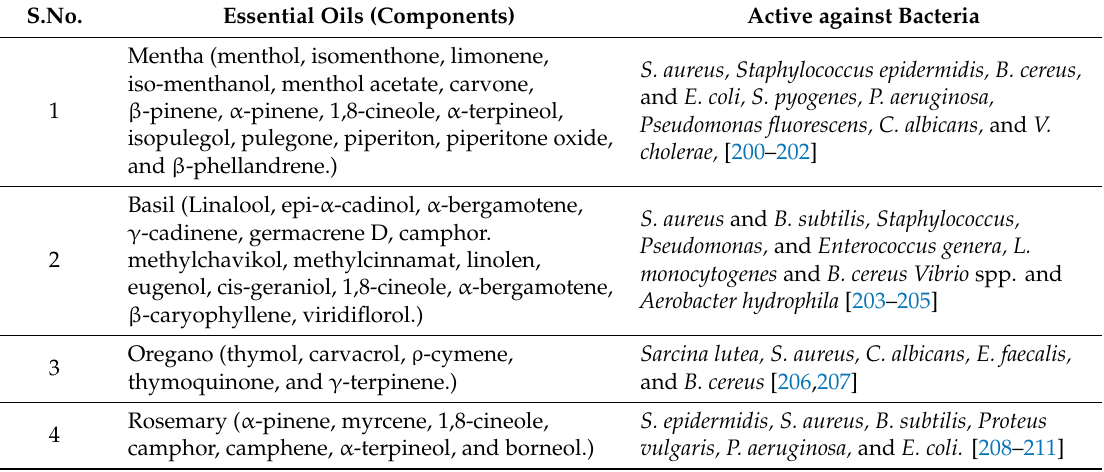
Table 6. E ff ect of essential oils against